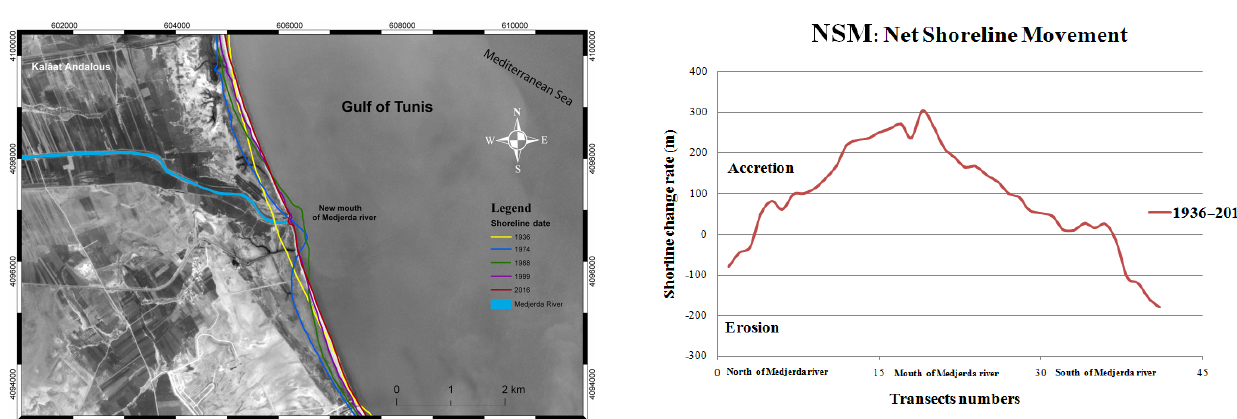
Figure 7. Multitemporal shoreline evolution of new mouth of Med- jerda river.